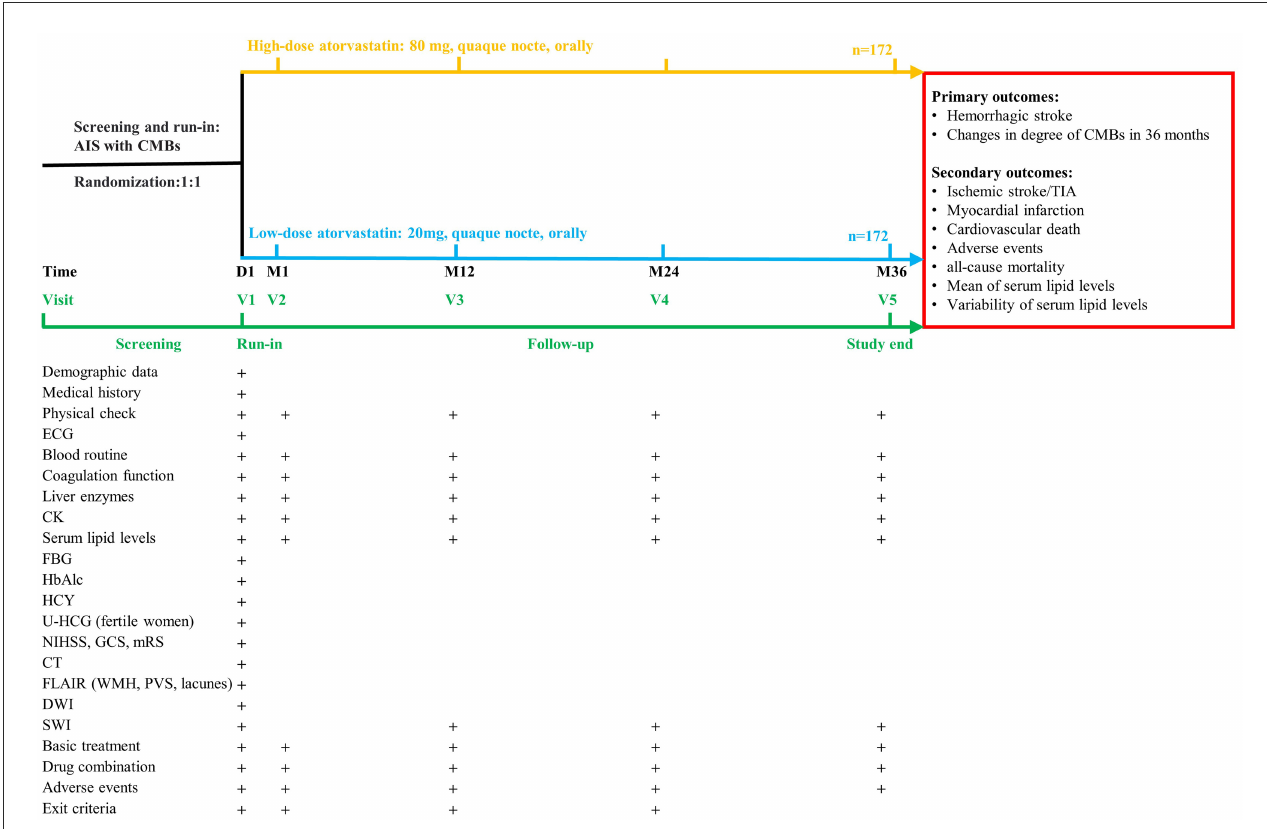
FIGURE1 Design of the CHRISTMAS trial. AIS, acute ischemic stroke; CK, creatine kinase; CT, computed tomography; CMBs, cerebral microbleeds; DWI, diffusion weighted imaging; ECG, electrocardiograph; FBG, fasting blood-glucose; FLAIR, fluid-attenuated inversion-recovery sequency; GCS, Glasgow Coma Scale; mRS, modified Rankin Scale; HbAlc, glycosylated hemoglobin; HCY, homocysteine; NIHSS, National Institutes of Health Stroke Scale; PVS, perivascular spaces; SWI, susceptibility weighted imaging; TIA, transient ischemic attack; U-HCG, urine human chorionic gonadotropin; ULN, upper limit of normal; WMH, white matter